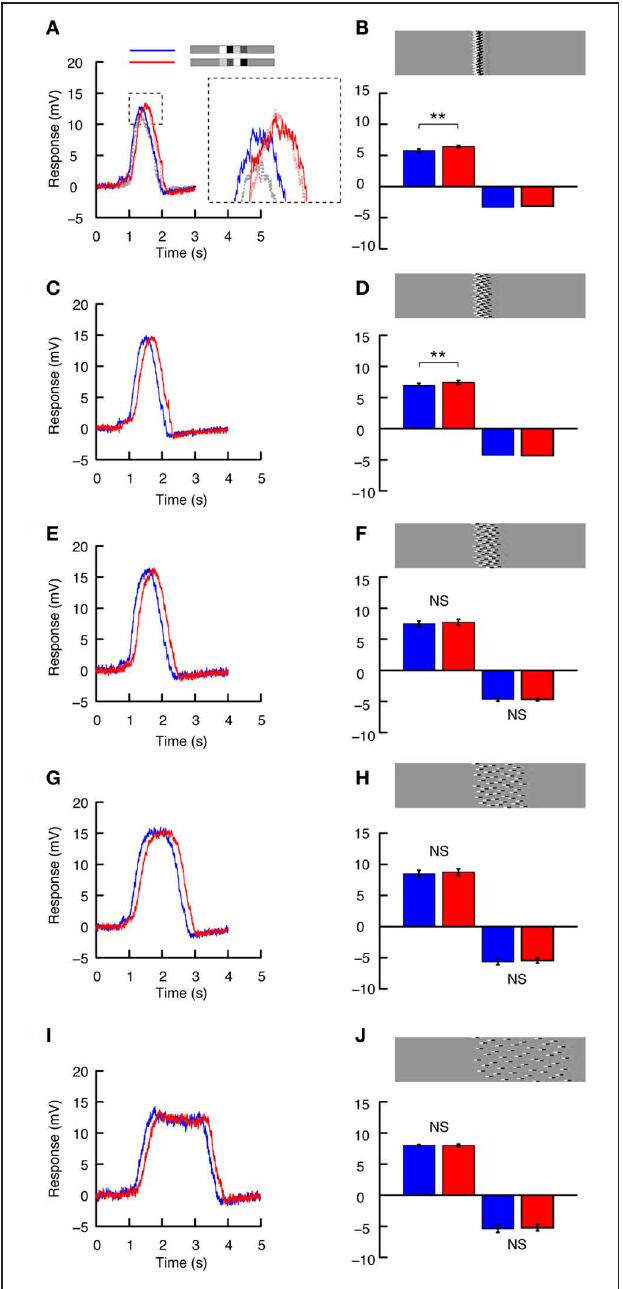
FIGURE 6 | The azimuthal distribution of features. (A) Intracellular HS neuron response to preferred direction motion for the image shown in part B, using the whole screen mode (blue = decreasing contrast, red = increasing contrast). The inset highlights the difference between the responses to this image (B) and that shown in Figure 5B (dashed gray = decreasing contrast, dashed light red = increasing contrast, data from Figure 5B ). (B) The doublet pair is broken up into individual 1.8 ◦ high segments, which are pseudo-randomly shifted horizontally, so that the maximum horizontal offset is 11 ◦ (The absolute spread of the ensembles horizontally is thus, 11 ◦ + the doublet pair width, 11 ◦ + 30 ◦ ). The bars show the mean response to motion in the preferred and anti-preferred direction.